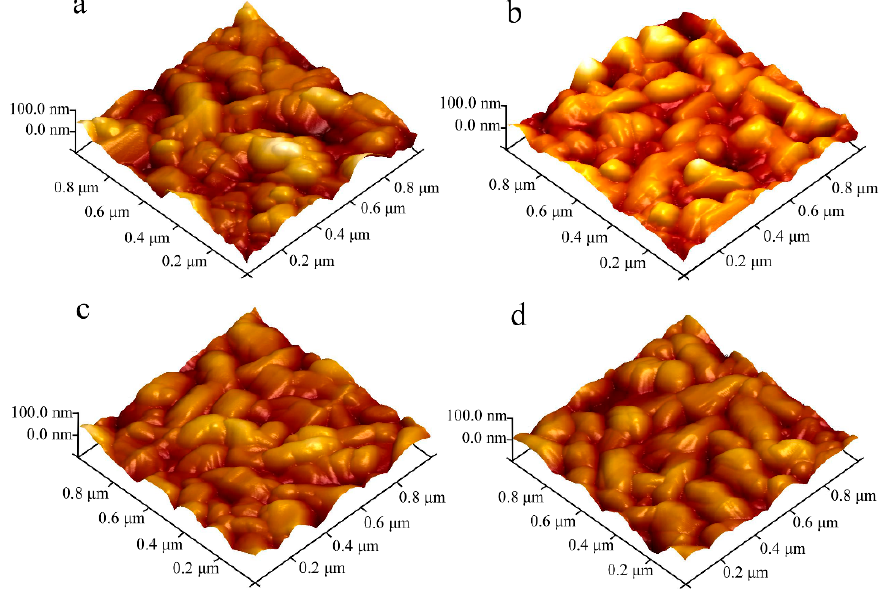
Figure 4. The three-dimensional (3D) surface images of the AFM measurements for the CuCr 1 − x Zn x O 2 , where x = ( a ) 0, ( b ) 0.025, ( c ) 0.065, and ( d ) 0.085.